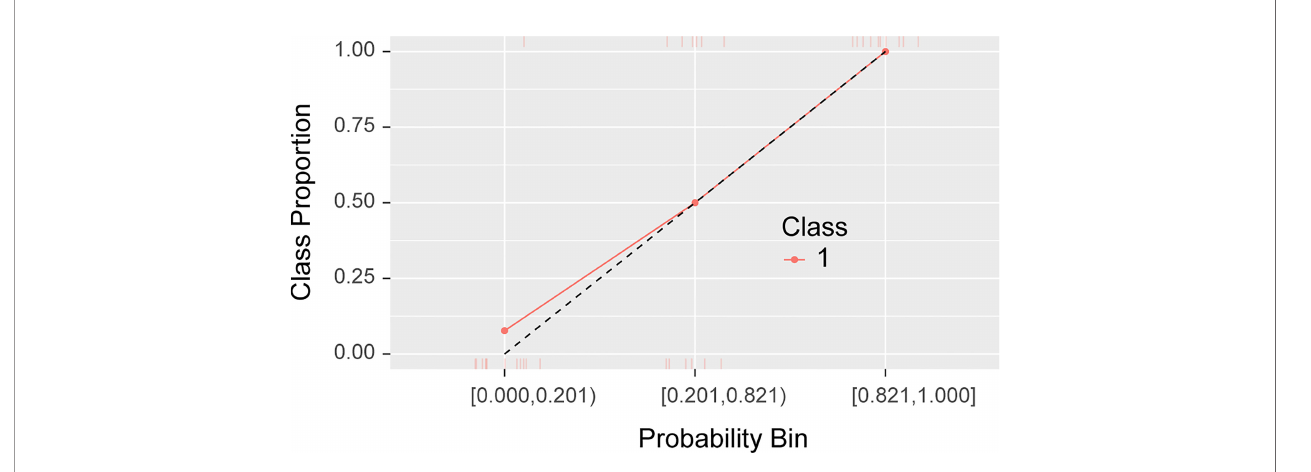
FIGURE 6 | Calibration curve of the radiomics random forest prediction